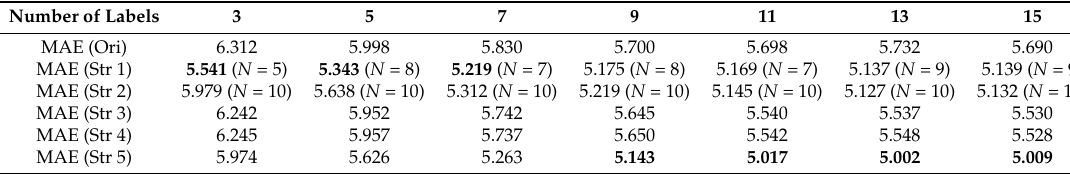
Table 9. MAEs of the compared original LDL algorithm without decision-making strategy and the proposed SDM-LDL algorithms with different strategies on the condition that age label distribution is generated as multi-label with equal description degrees (number of age labels from 3, 5, 7, ... to 15; for Strategies 1 and 2, best results are shown in the table along with the value of N then; for every number of age labels, the optimal MAEs are marked in